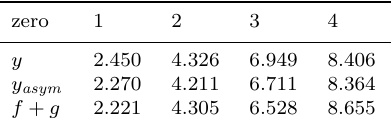
Table 1. Zeros of fractional oscillations as in (3.14) with y (0) = 0, y (cid:48) (0) = 1, α = 0 . 75, λ = − 2 and q ( x ) = 1 (Mittag-Leffler function). Zeros in rows from the top: exact solution, approximate solution (3.16) and approximate formulas (4.4) and (4.5). zero 1 2 3 4 y